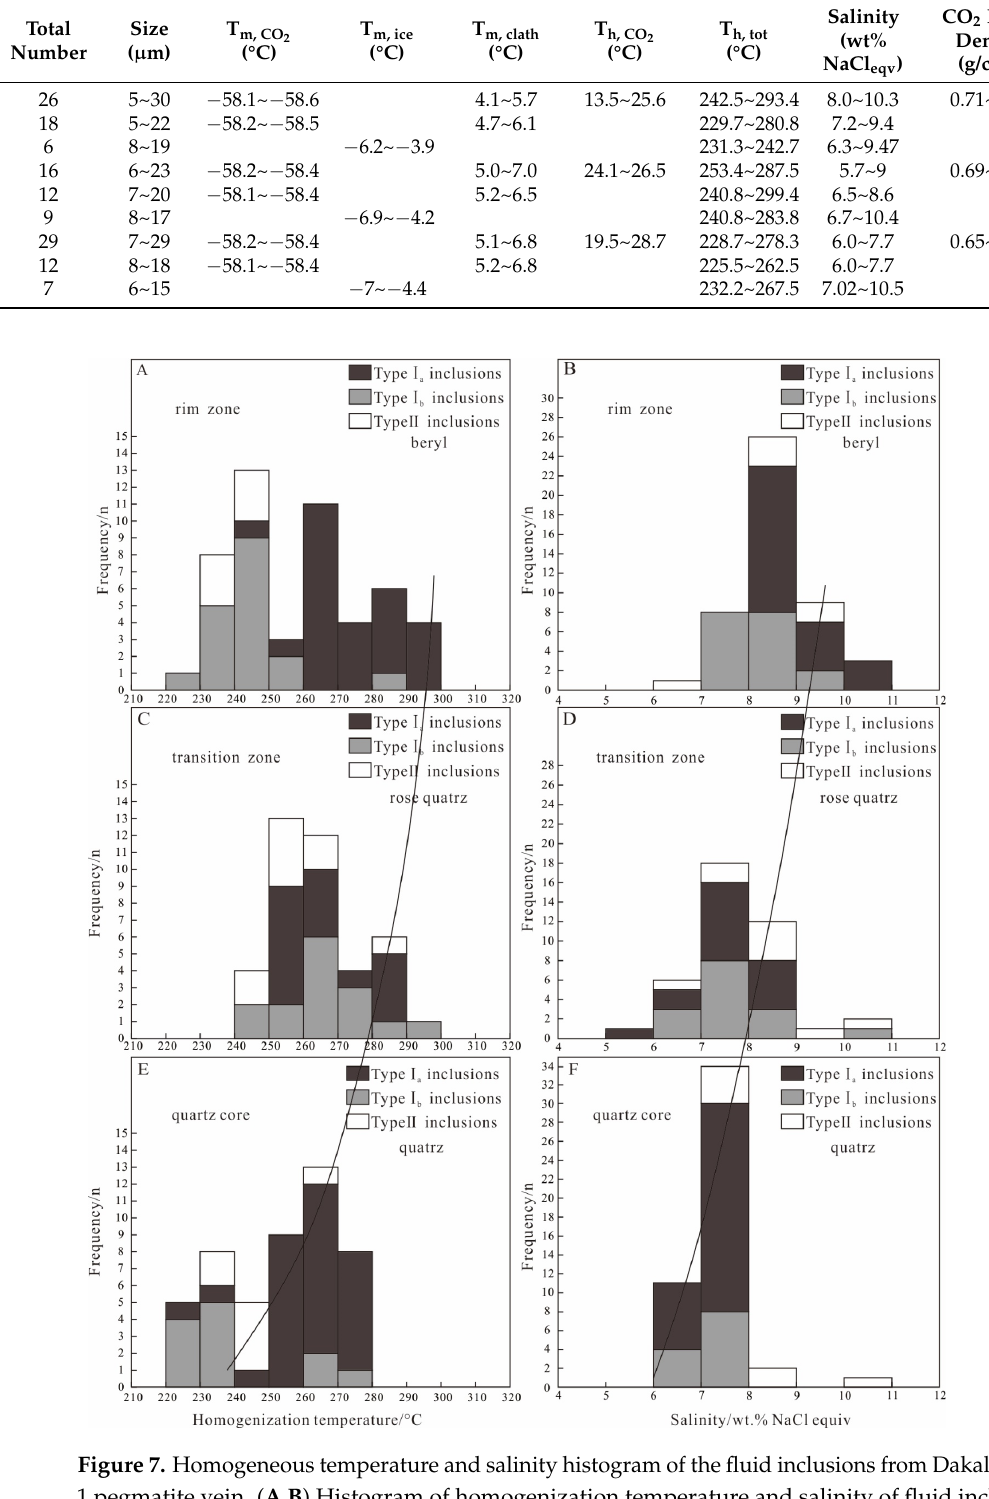
Table 1. Micorothermometry results of the fluid inclusions from Dakalasu No. 1 pegmatite vein.